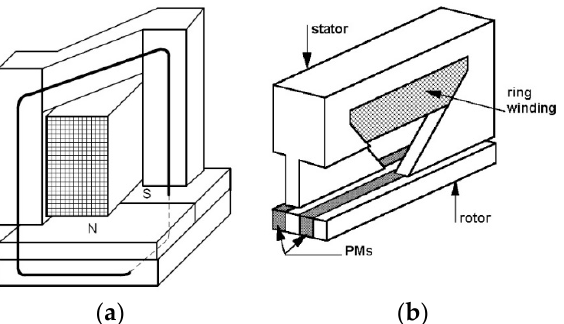
Figure 5. Proposed methods of the flux leakage reduction presented in publications: ( a )—twisted stator cores [10] © [2005] IEEE. Reprinted, with permission, from [Gieras, J.F. Performance Charac- teristics of a Permanent Magnet Transverse Flux Generator. In Proceedings of the IEEE Conference on Electric Machines and Drives, San Antonio, TX, USA, 15 May 2005; pp. 1293–1299.